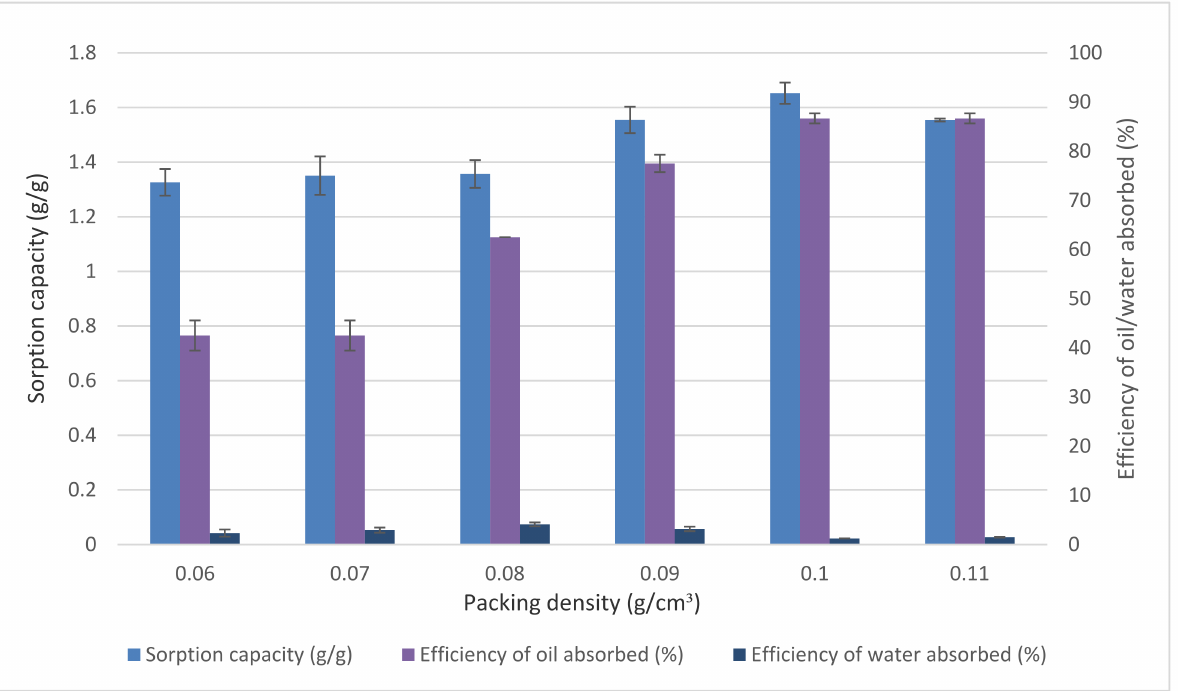
Figure 7. Effects of packing density on EFB treated fibre. Data obtained were the average efficiency of oil absorbed (%), the efficiency of water absorbed (%), and sorption capacity (g/g) on temperature. Vertical bars indicate SEM of three